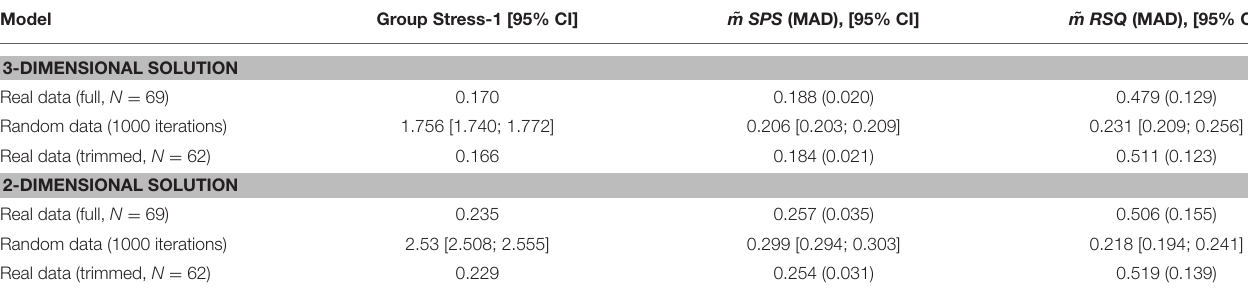
TABLE 1 | Model fit results for study